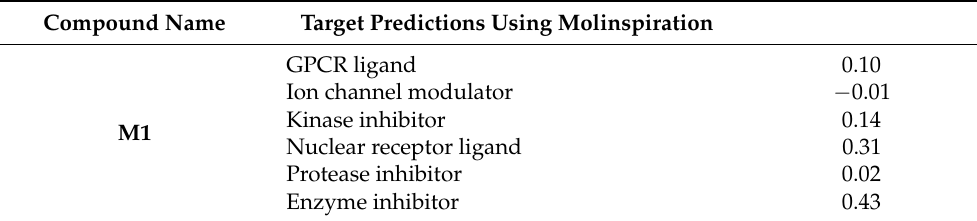
Table 3. Predicted biological targets of A. fragrantissima flower dichloromethane extract-derived metabolites using Molinspiration